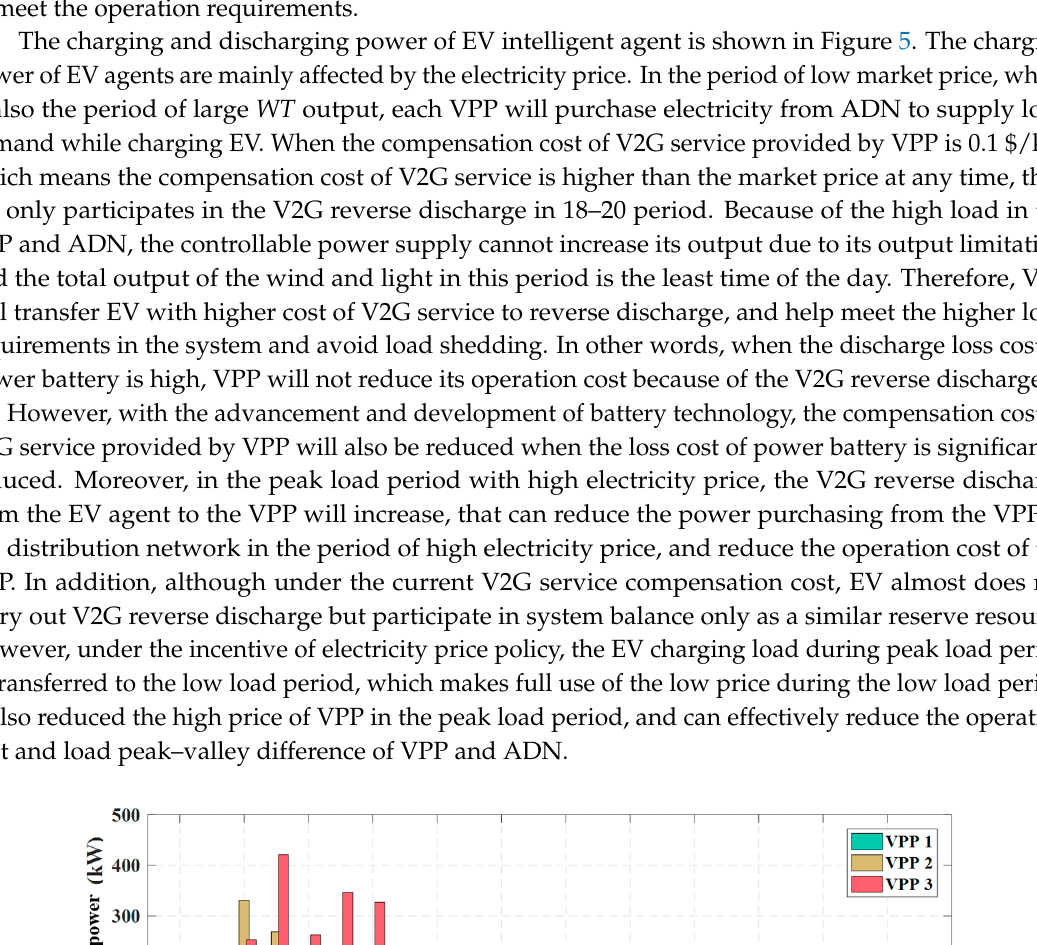
Nodes Figure 6. Node voltage level of AND. Taking the typical time periods 3, 9, 15, and 20 as examples, the convergence performance of the dispatching method that proposed in this paper was analyzed. Active power interaction between ADN and VPP converged after 16 iterations, as shown in Figure 7. The total operation cost of traditional centralized two-stage stochastic scheduling was compared with that of decentralized two- stage stochastic scheduling, as shown in Figure 8. It can be seen that the total operation cost of centralized two-stage stochastic scheduling is 2303$. After 16 iterations, the total cost of decentralized two-stage stochastic scheduling converges to 2361$. This shows that the calculation effect of decentralized two-stage stochastic optimization based on ADMM is very close to centralized optimization and can converge after finite iterations.